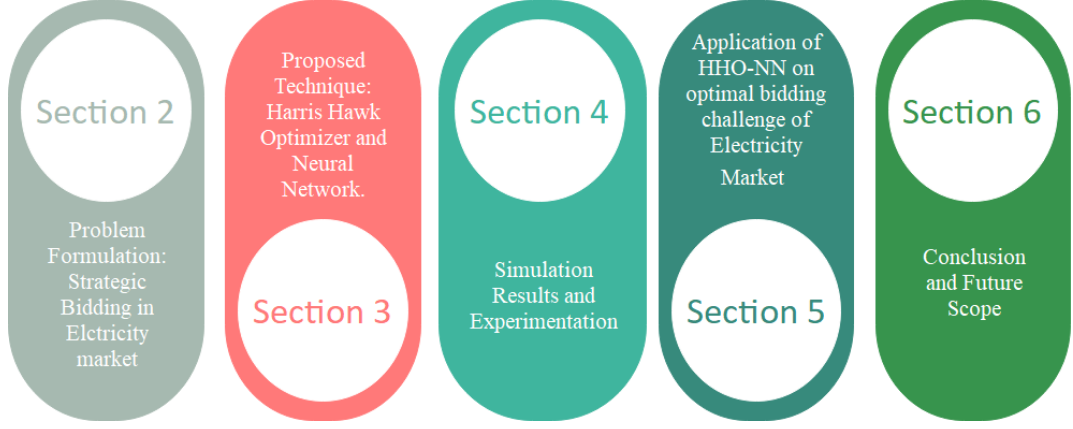
Figure 2. Systematized format of manuscript.